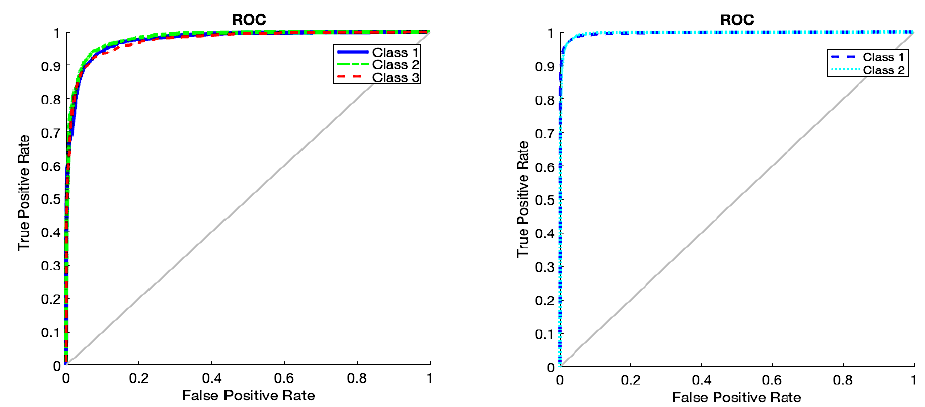
Figure 14. The ROC diagram for classifying two-class and three-class scenarios for F3 and C3 channels. Table 2. The accuracy of the intended channels for classifying two-class and three-class scenarios.